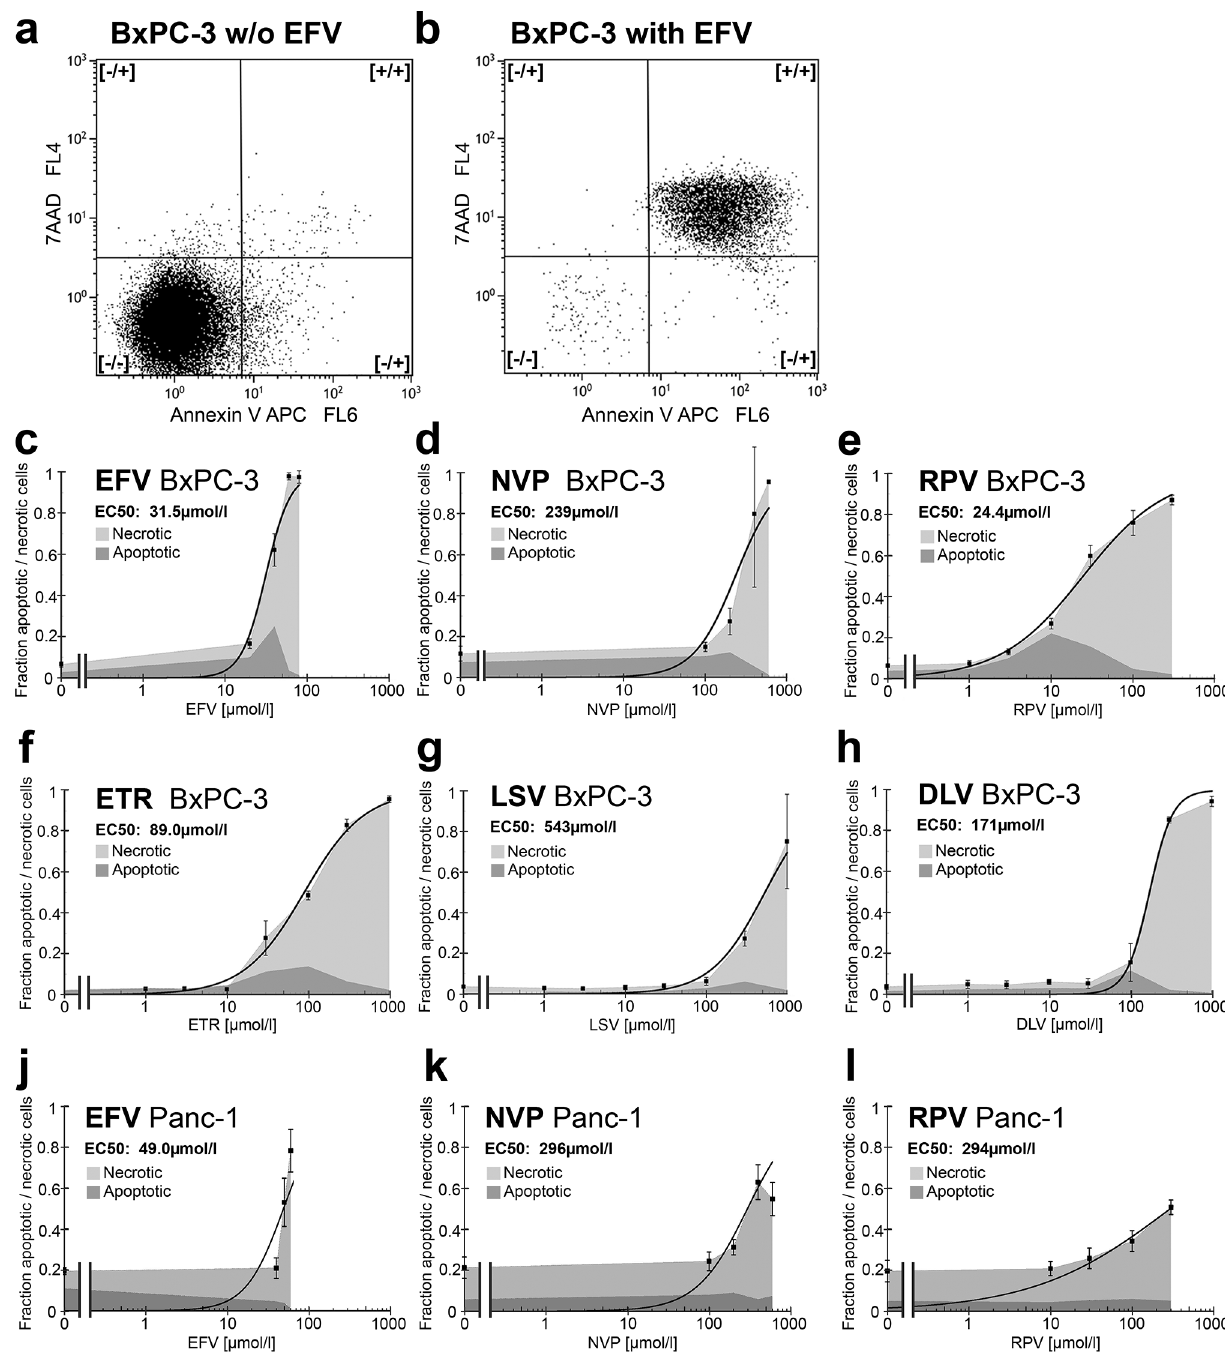
Fig 2. Apoptosis and necrosis induction in cancer cells by non-nucleoside reverse transcriptase inhibitors. The fraction of apoptotic and necrotic cells after treatment with different NNRTIs in different concentrations was measured by Annexin-V-APC/7AAD staining and flow cytometry. An example of the gating in the FACS plots is shown for untreated (a) and with a toxic concentration of EFV treated cells (b). A curve was fitted through the data points of the total fraction of dead cells and the EC50 was calculated for each drug. The pancreatic cancer cell line BxPC-3 was treated for 72h with (c) EFV, (d) NVP, (e) RPV, (f) ETR, (g) LSV and (h) DLV. The pancreatic cancer cell line Panc-1 was treated for 72h with (j) EFV, (k) NVP and (l)